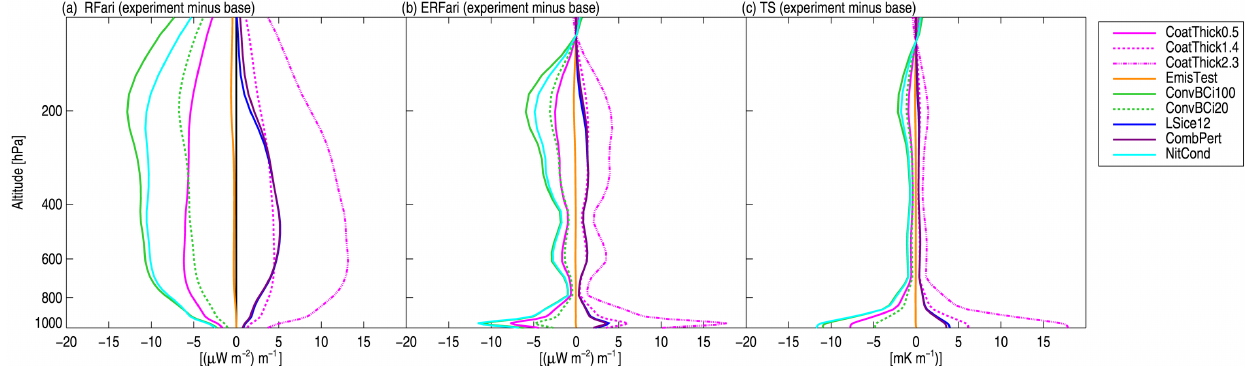
Figure 7. Change in (a) RFari, (b) ERFari and (c) TS between each sensitivity experiment and the base simulation as a function of altitude.